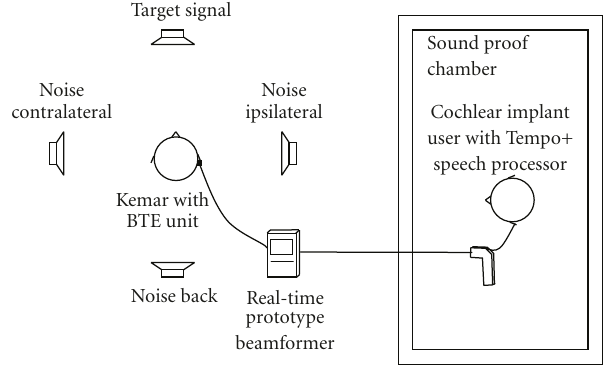
Figure 7: Experimental setting for speech intelligibility tests in noise with cochlear implant users.